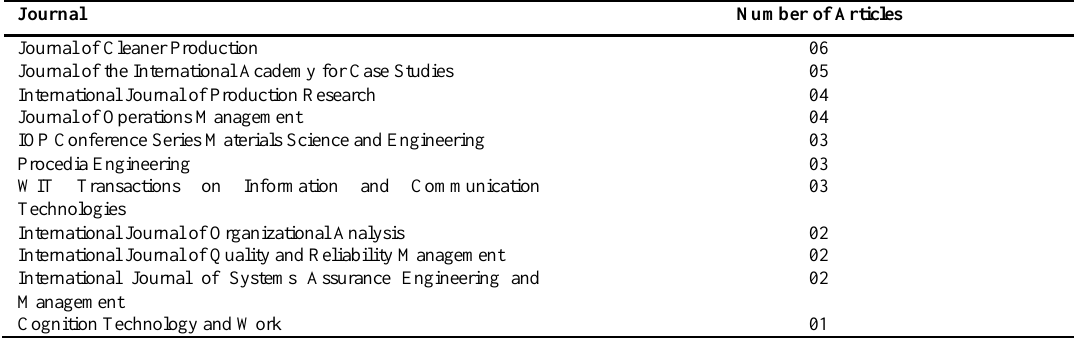
Table 4. Journal-wise publications: intellectual capital and operational